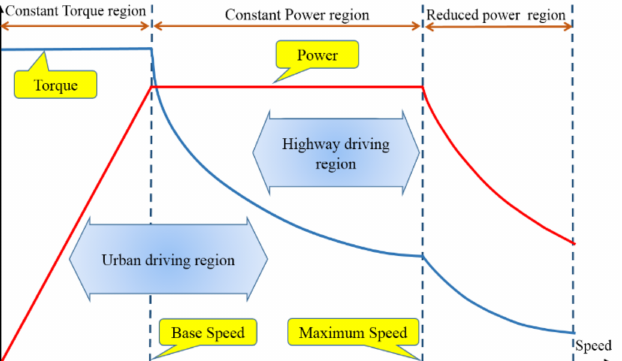
Figure 6. Typical speed–torque characteristics of EV electric traction motors.